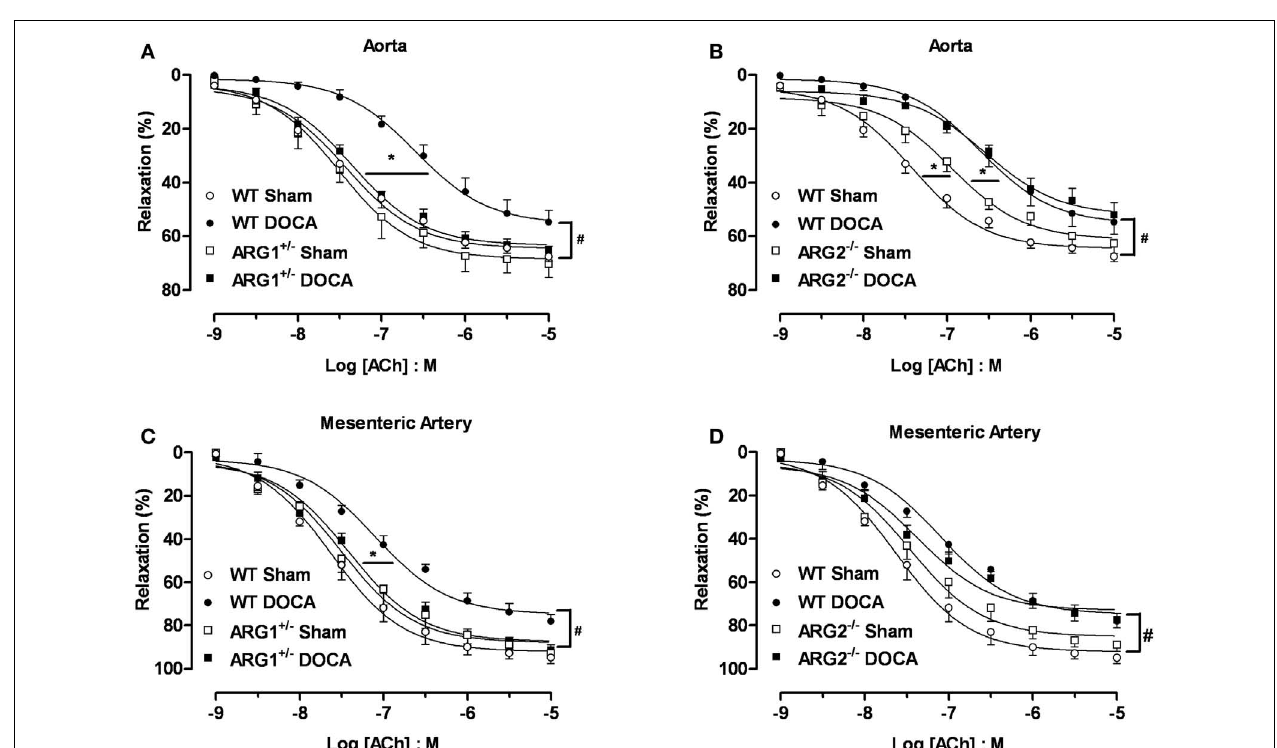
were calculated relative to the maximal changes from the contraction produced by phenylephrine (PE, 1 µ M), which was taken as 100%. Data are means ± SEM of six to eight experiments. * P < 0.05, indicates differences in pEC 50 values of the dose-response curves. # P < 0.05, compared withWT Sham